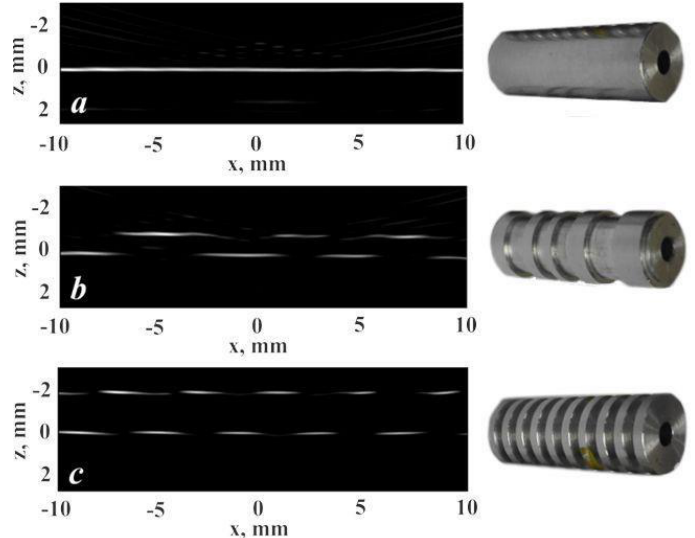
Figure 6. LU images 𝜖(𝒓) of the duralumin samples reconstructed using filtered back-projection algorithm: ( a ) a cylinder 14 mm in diameter, ( b ) a cylinder 14 mm in diameter with irregular grooves 1 mm in depth, and ( c ) a cylinder 14 mm in diameter with regular grooves 2 mm in depth. Reproduced with permission from [52], OSA Publishing, 2018.